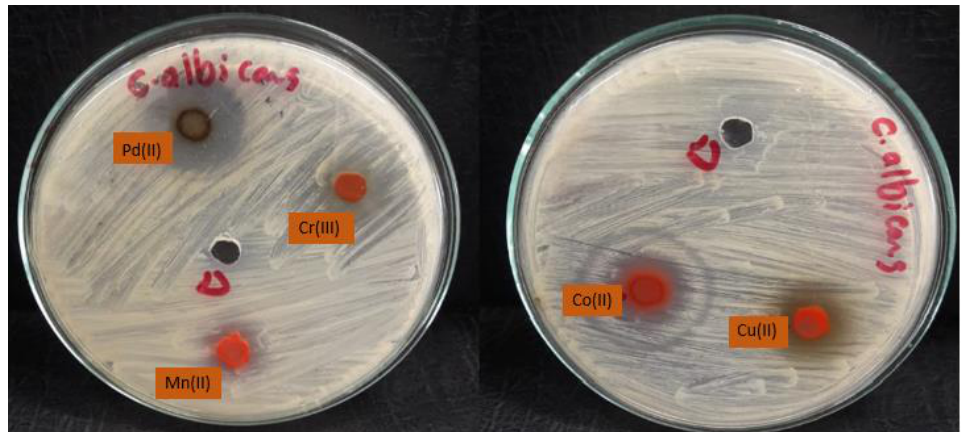
Figure 12. Microbiological screening of coordination compounds of Mn(II), Co(II), Cu(II), Cr(III), and Pd(II) toward Cryptococcus neoformas.